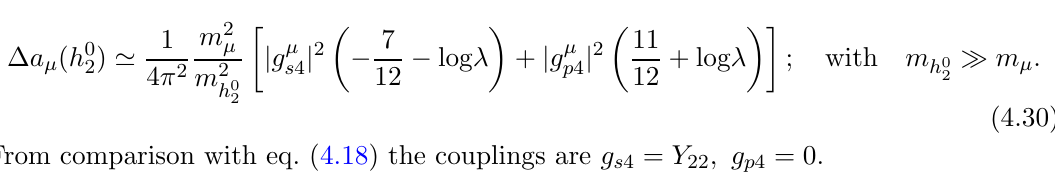
( (cid:30) 0 (cid:22) 1